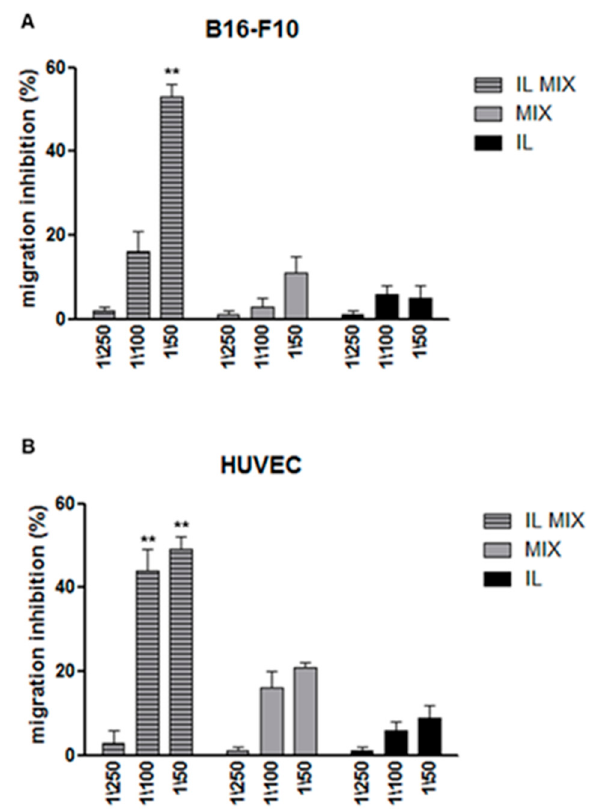
Figure 4. Migration assay. ** IL MIX vs. MIX p < 0.01; ( A ) B16-F10 cells; ( B ) HUVEC. IL: Intralipid ® ; MIX: combination of drugs; IL MIX: MIX co-loaded in IL.